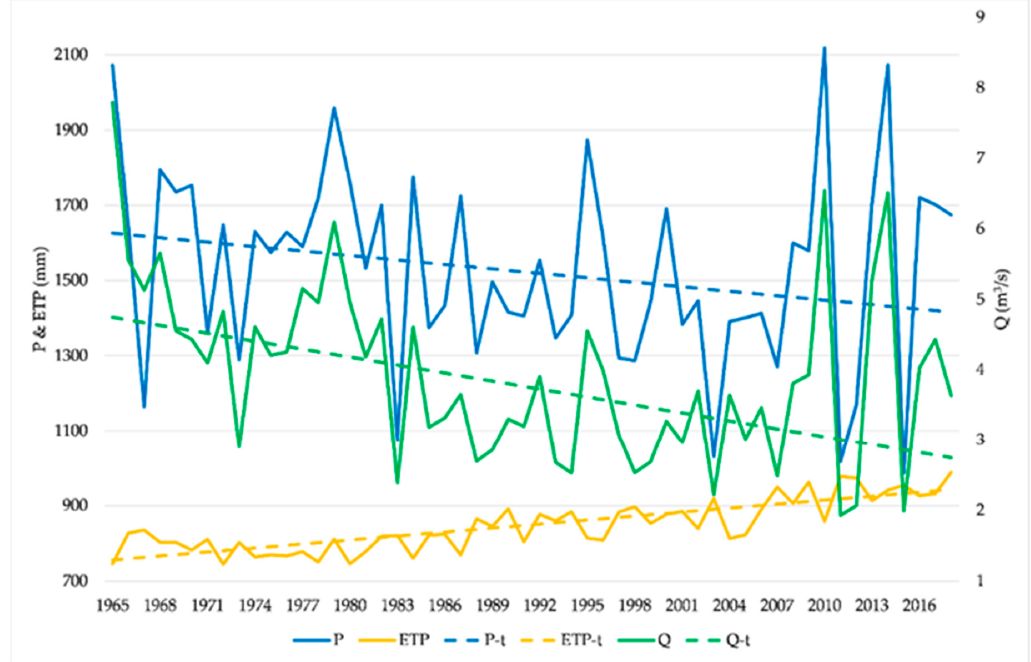
Figure 3. Yearly discharge (Q) of the Rižana River, precipitation (P) and ETP in the catchment in the period 1962–2018 with trend lines (t).